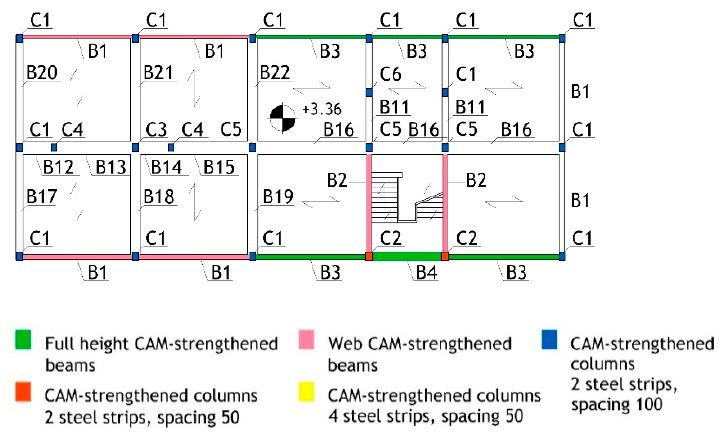
Figure 13. Localization of the interventions—ground storey—and nomenclature for all storeys.